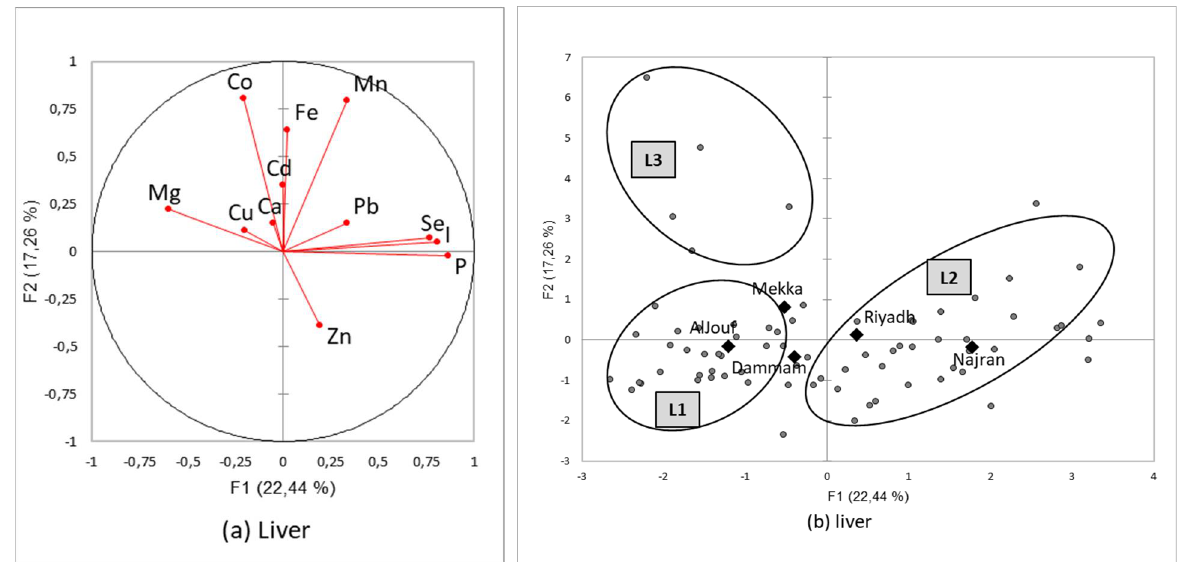
Figure 4. Correlation circles ( a ) for the two first factors of the Principal Components Analysis demonstrating the relationships between minerals in camel liver, and the main factorial plan ( b ) with representation of the three mineral patterns of the liver sampled in Saudi slaughterhouses from five regions and during two seasons (squares represents the mean value for each region and dots the different liver sample values).